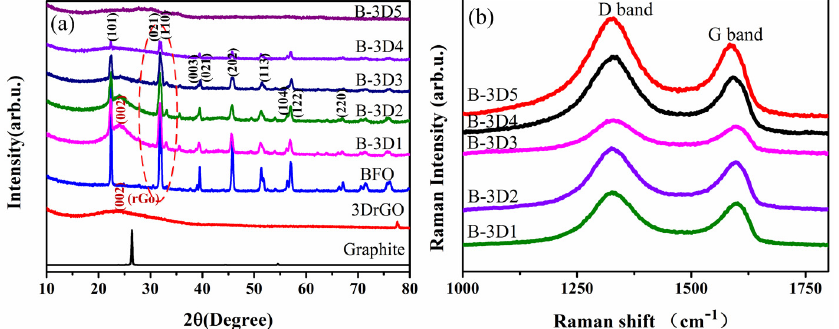
Figure 3. ( a ) X-ray diffraction patterns and ( b ) Raman spectra of the 3D BFO/graphene composite samples with different GO concentrations.